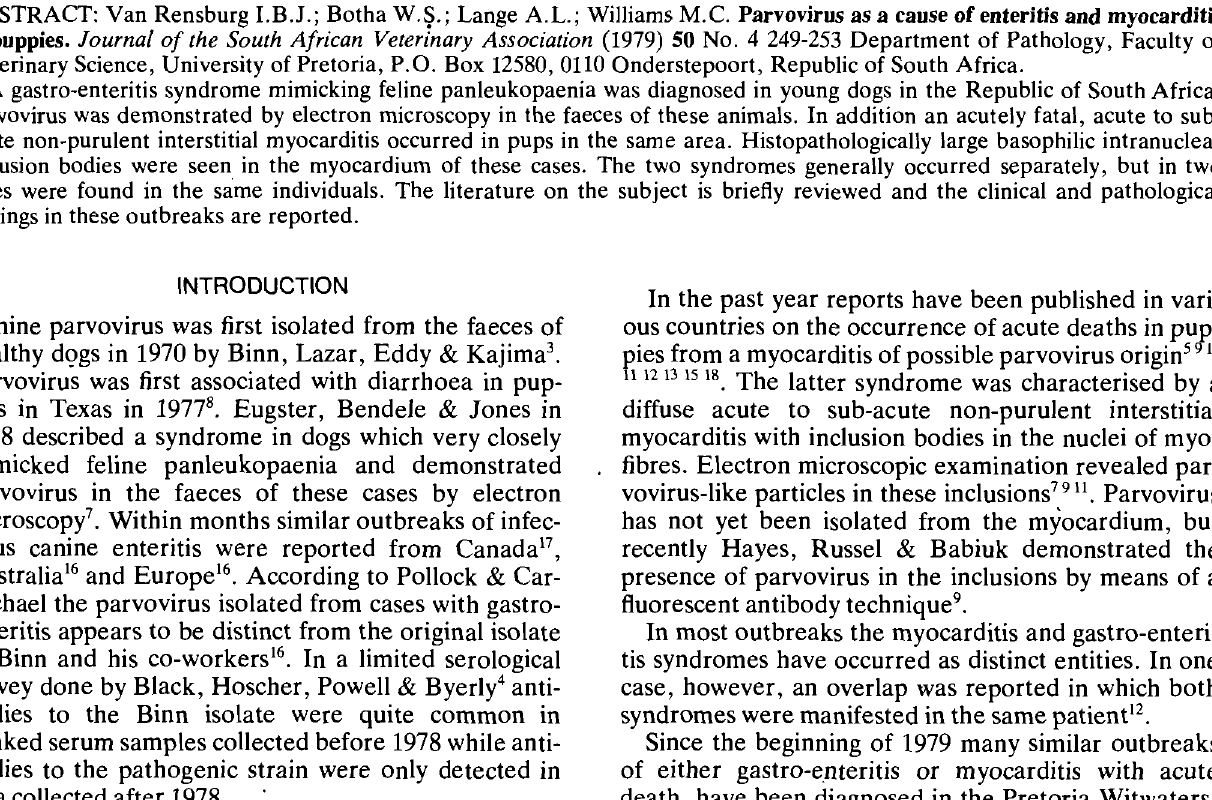
Table 1: SUMMARY OF MAJOR FINDINGS IN SOME OF THE CASES